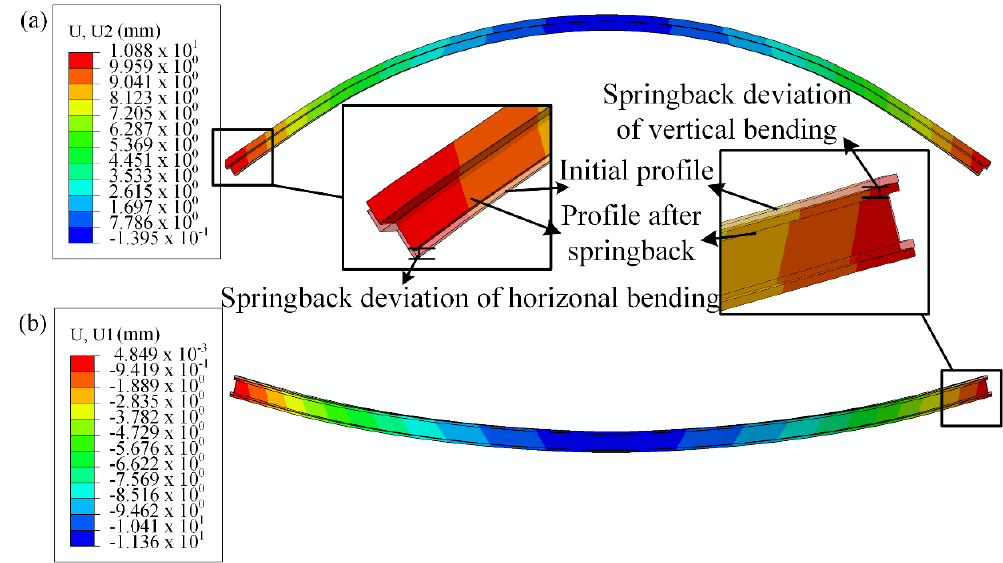
Figure 5. Characterization of springback. ( a ) Definition of springback deviation of horizontal bending. ( b ) Definition of springback deviation of vertical bending.